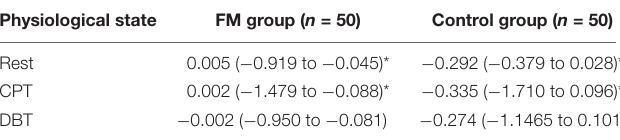
Data are expressed as median with interquartile range in parentheses. Statistics: Mann–Whitney U-test. bpm, beats per minute; CPT, cold pressor test; DBT, deep breathing test. * p <